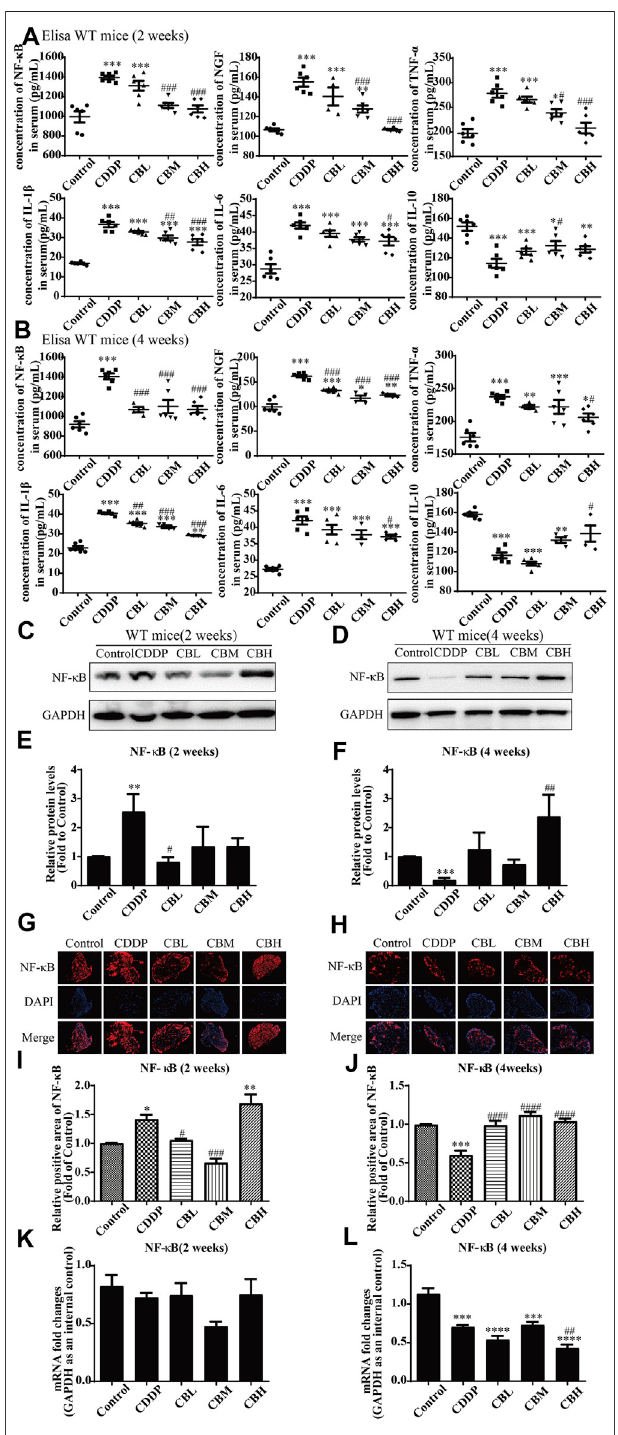
FIGURE2| BBRreducesin fl ammationinserumandtheoverexpression of NF- κ B protein in DRG in CDDP model of WT mice. (A,B) The effect of BBR on serum levels of in fl ammatory factors NF- κ B, NGF, TNF- α , IL-1 β , IL-6 and IL-10 were in CDDP-induced mice by ELISA. CDDP induced NF- κ B ( F (cid:1) 17.81, p < 0.001), NGF ( F (cid:1) 28.46, p < 0.001), TNF- α ( F (cid:1) 17.34, p < 0.001), IL-1 β ( F (cid:1) 49.53, p < 0.001), and IL-6( F (cid:1) 20.90, p < 0.001) up-regulation in